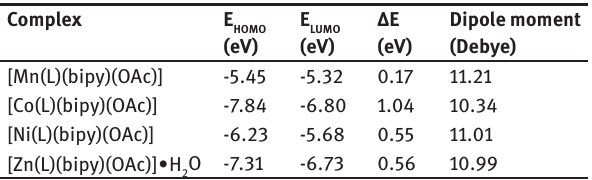
Figure 4: Optimized structures of metal-ligand complexes with bond distances obtained at B3LYP/ 6-31+G(d,p)+LANL2DZ.